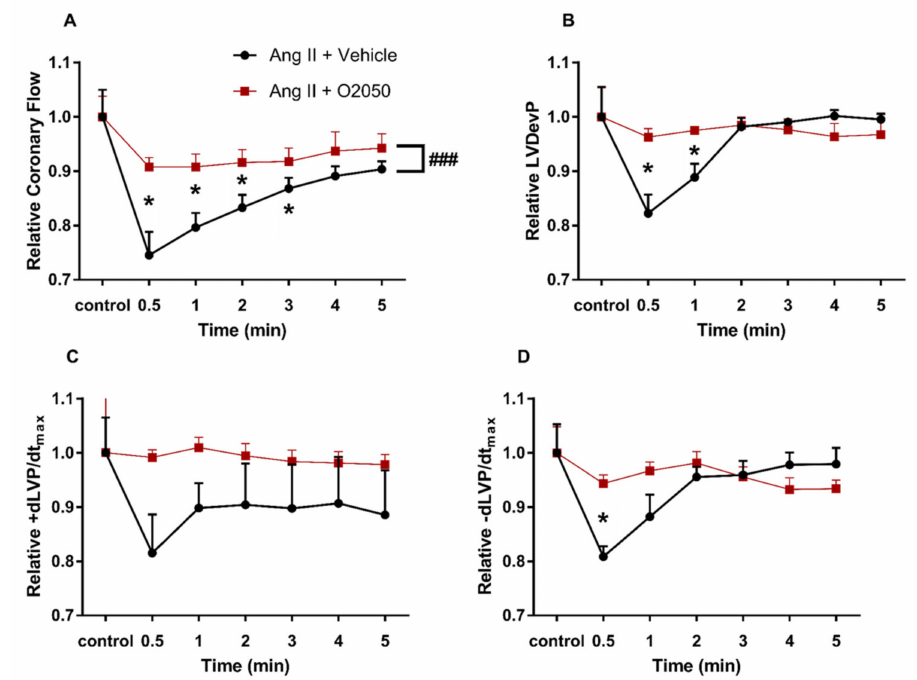
Figure 5. Influence of CB 1 R inhibitor O2050 on the effects of angiotensin II (Ang II) on coronary flow ( A ), left ventricular developed pressure (LVDevP) ( B ), +dLVP/dt max ( C ) and − dLVP/dt max ( D ) of isolated rat hearts. Ang II (10 − 7 M) was administered repetitively to the perfusate. The presented data were recorded during the second infusion period, when Ang II was infused either in the presence of CB 1 R inhibitor O2050 (10 − 6 M) or its vehicle and are expressed as relative values compared to pre-infusion control data. Mean ± SEM; n = 7 & 8; * p < 0.05 vs. control (pre-infusion value); ### p < 0.001 vs. vehicle; two-way repeated measurement ANOVA and Dunnett’s post-hoc test.